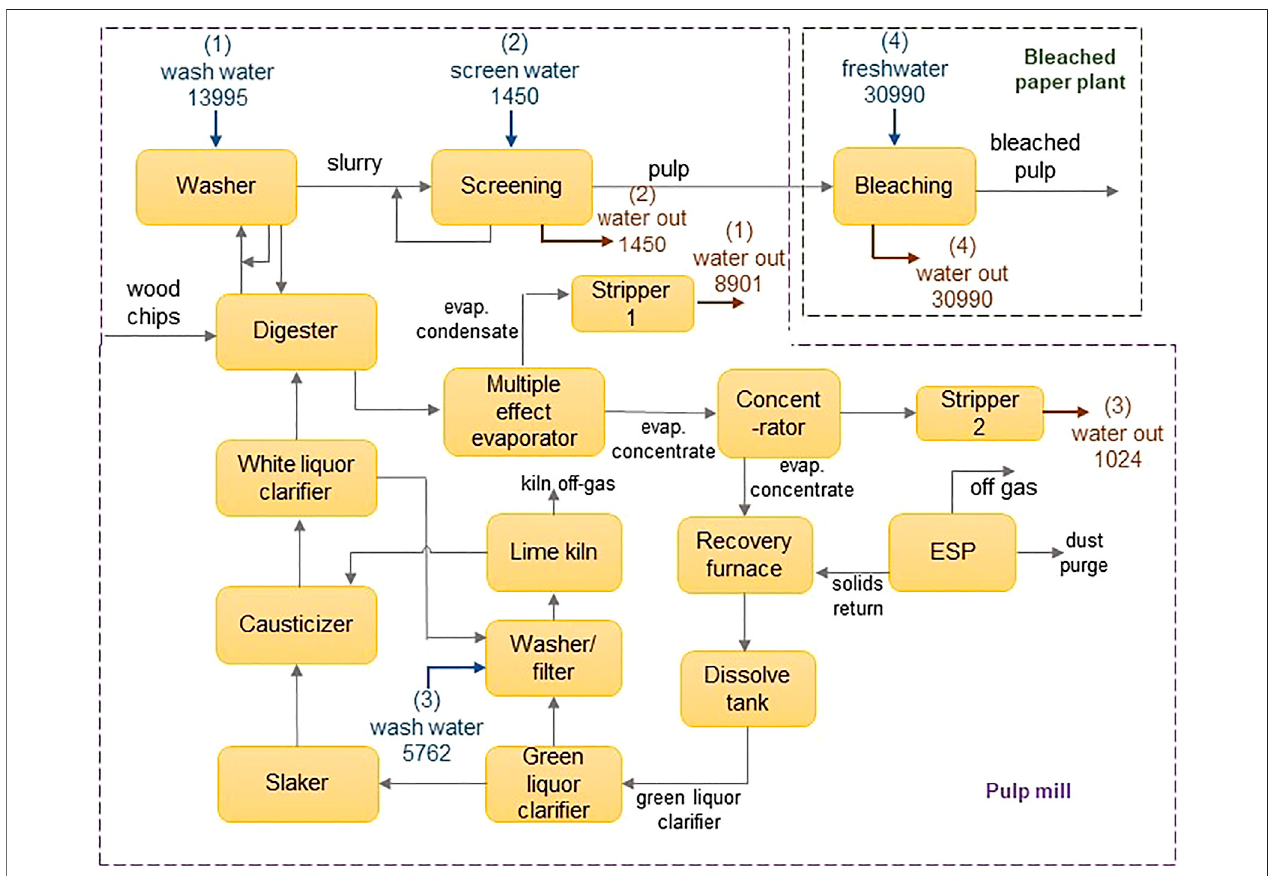
FIGURE 3 | Process fl owsheet for the integrated pulp mill and bleached paper